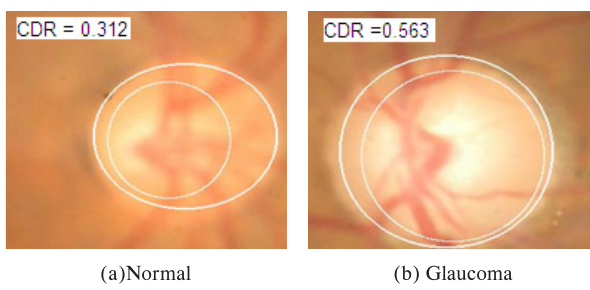
Fig. 1. CDR computations with elliptical fitting for optic cup and optic disc (SWFCM method).